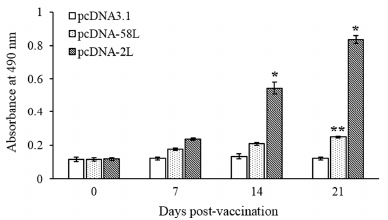
Figure 3. Serum antibody response in vaccinated Chinese giant salamanders. Sera were collected from Chinese giant salamanders at 0, 7, 14, and 21 days after vaccination, and serum antibodies against ADRV were determined by using indirect ELISA. Data are presented as means ± SE ( n = 4). Asterisks indicate significant differences from the pcDNA3.1 group. * p < 0.05, ** p < 0.01.